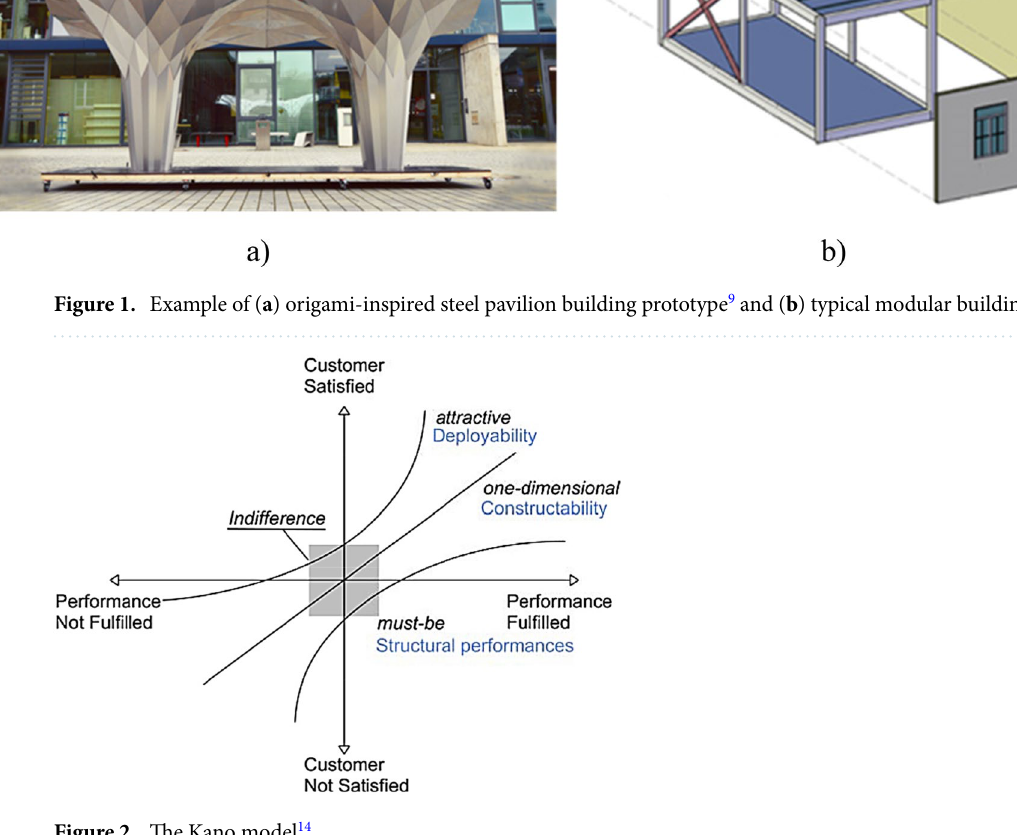
Figure 2. The Kano model 14